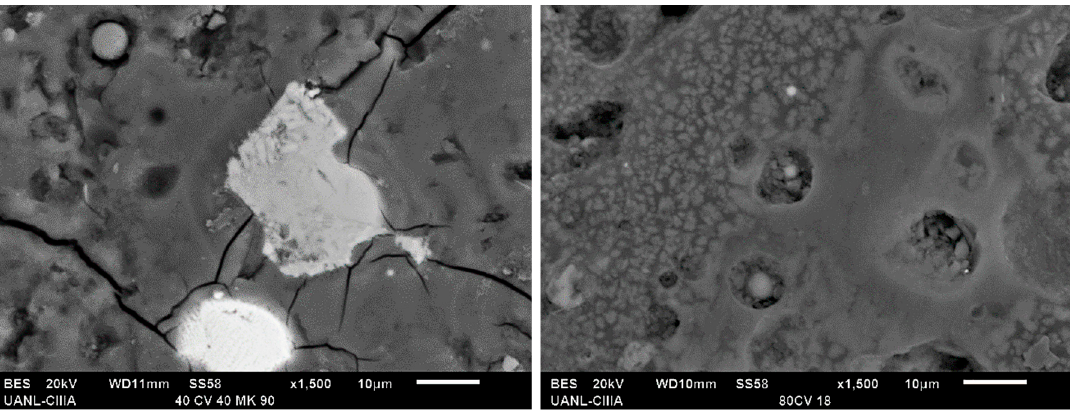
Figure 6. Fly ash particles in the pores of the cementitious matrix .